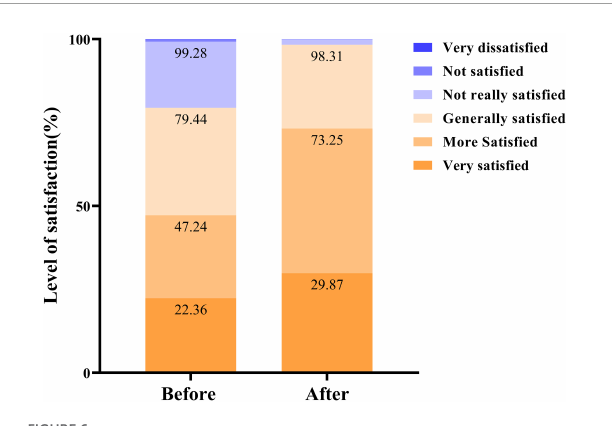
FIGURE6 Comparison of resident satisfaction before and after project